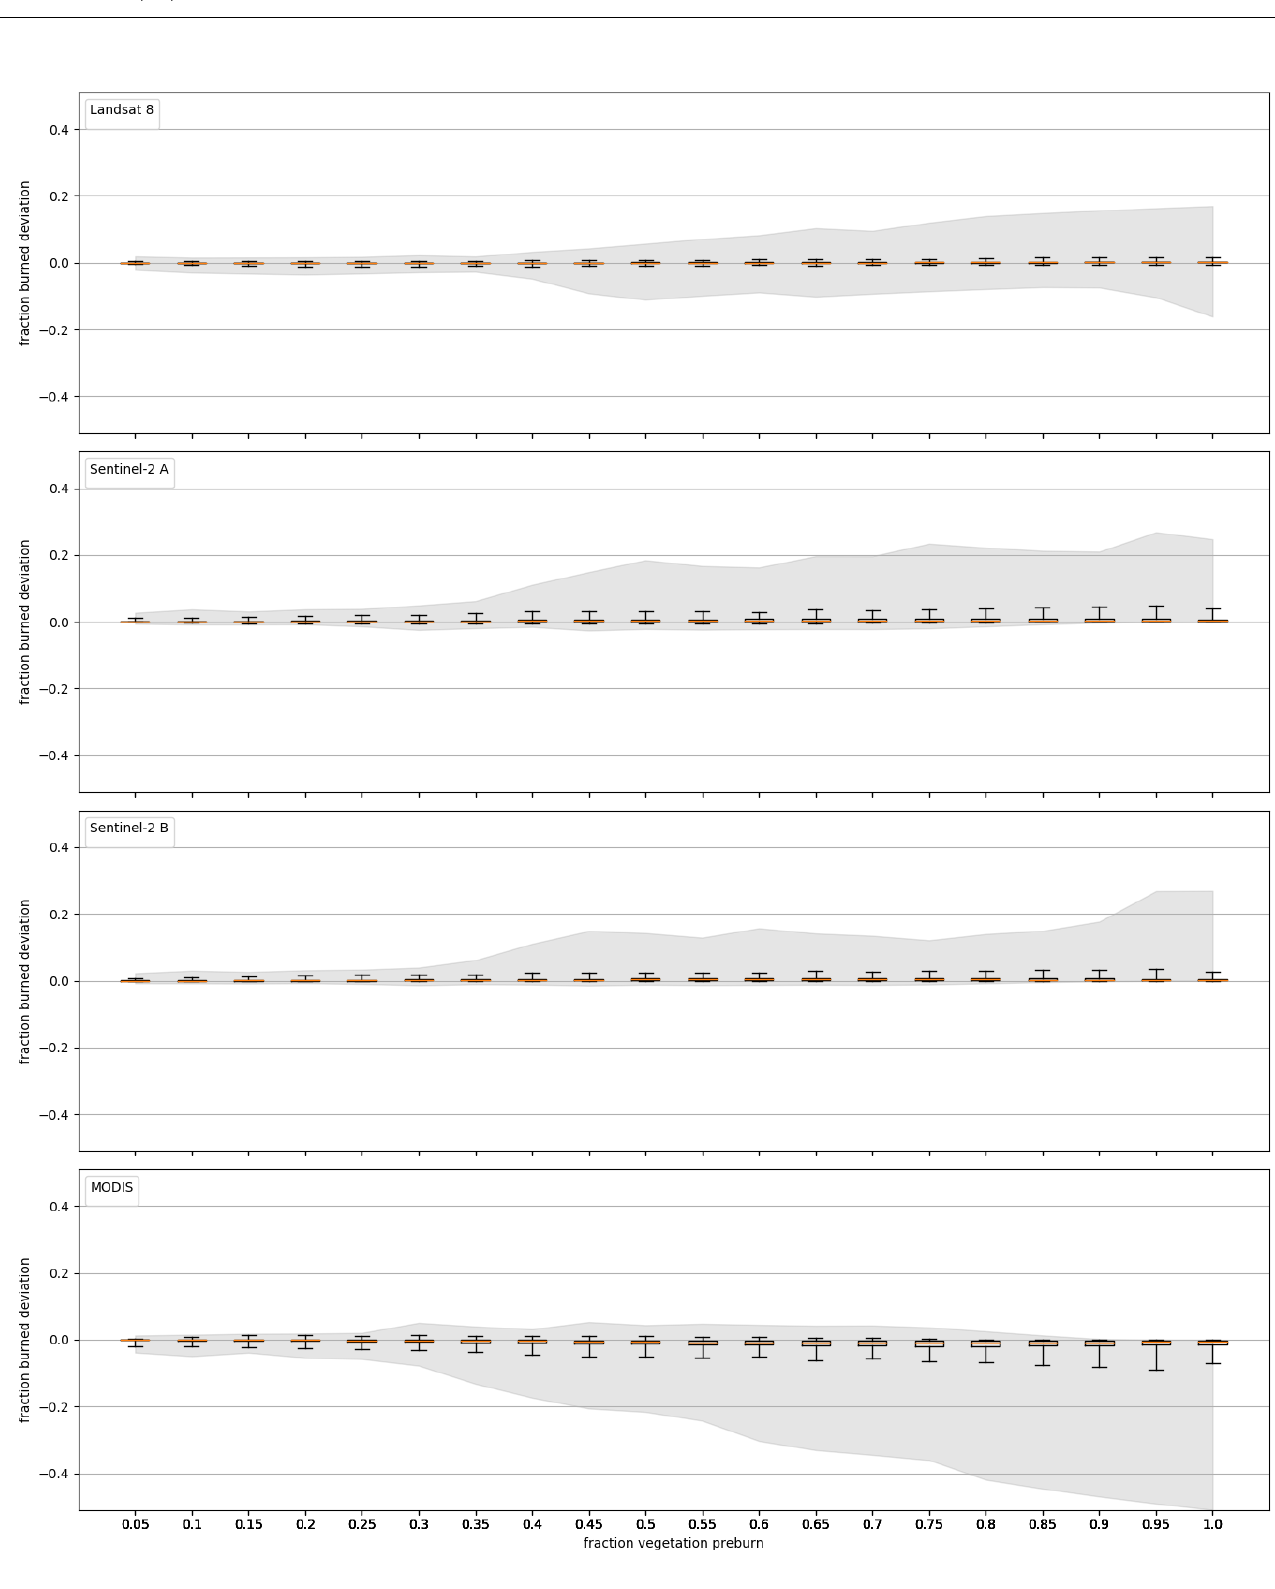
Figure 3. Deviation from mean of satellite instruments of burned fraction required for detection as a function of starting vegetation fraction. This compares model results with equal parameter settings and sample combinations when measured with the different satellite sensors. From top to bottom: Landsat 8, Sentinel-2 A, Sentinel-2 B, and the Moderate Resolution Imaging Spectroradiometer (MODIS). Total variation within the model results are shown in gray, while distribution of the expected (mean) values are shown in